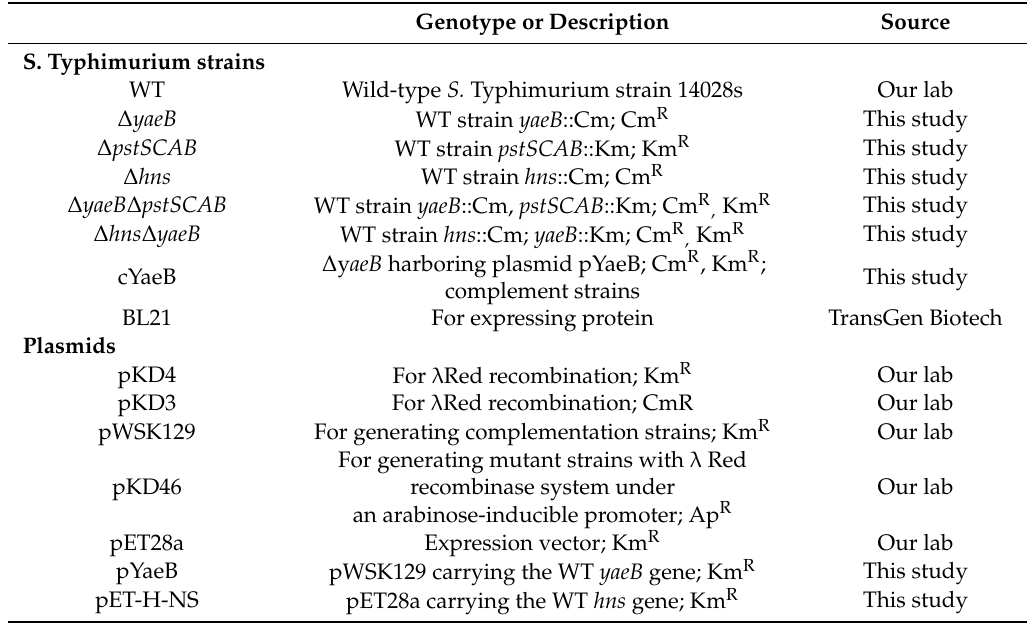
Table 1. Bacterial strains and plasmids used in this